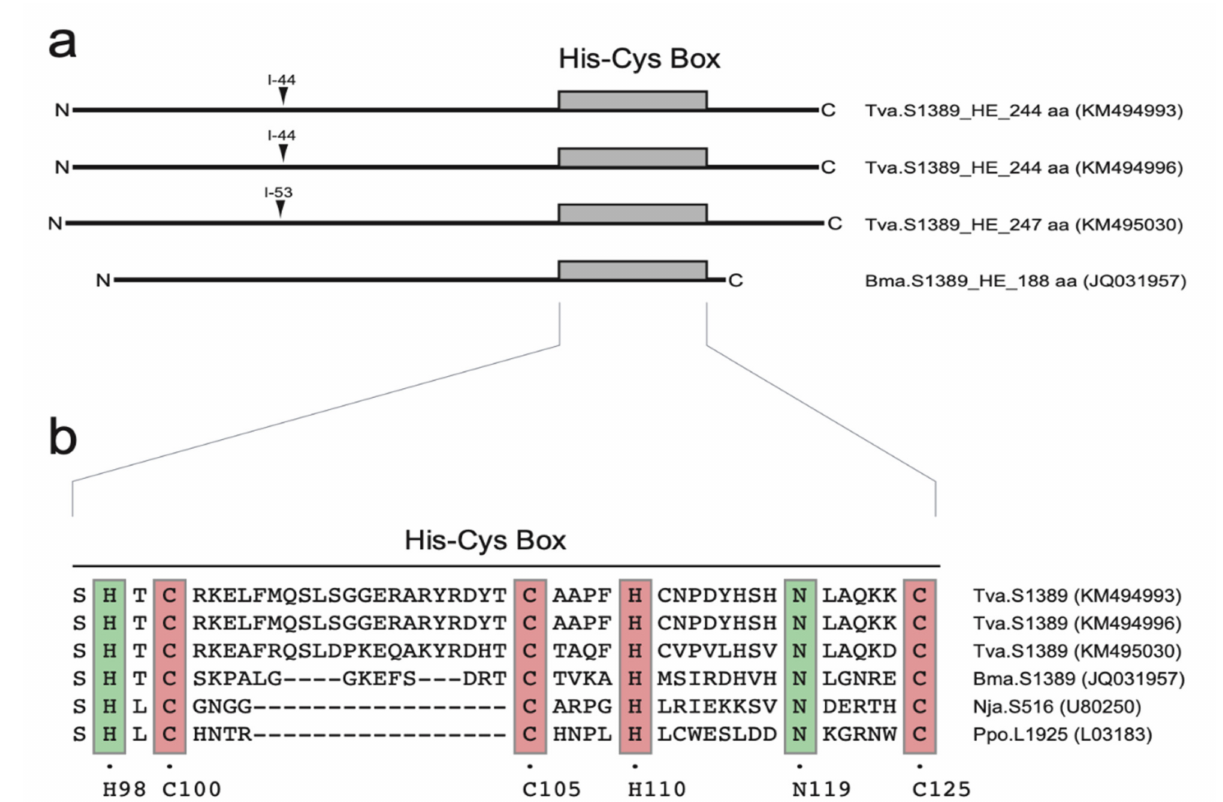
Figure 4. His-Cys homing endonucleases encoded by S1389 group I introns. ( a ) Schematic organization of S1389 intron homing endonucleases including N and C terminal ends, and the characteristic His-Cys box. Trichia varia homing endonu- clease genes (HEGs) are interrupted by small spliceosomal introns (I-44 and I-53). ( b ) Amino acid alignment of His-Cys box features. The Naegleria (I- Nja I; Nja.S516) and Physarum (I- Ppo I; Ppo.L1925) represent well-studied His-Cys homing endonucleases. Conserved residues (boxed) corresponding to those presented in the I- Ppo I crystal structure [26]. C100, C105, H110, and C125 are involved in zinc binding, and H98 and N119 are associated with the active